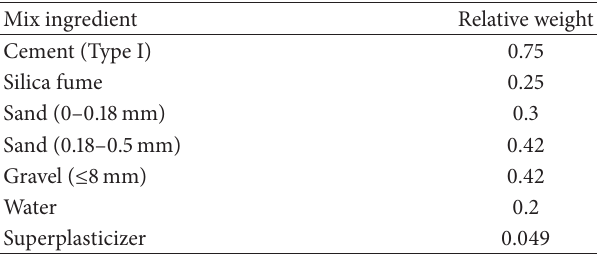
Figure 3: Copper-coated steel fiber. Table 1: Ultrahigh performance concrete mix design.